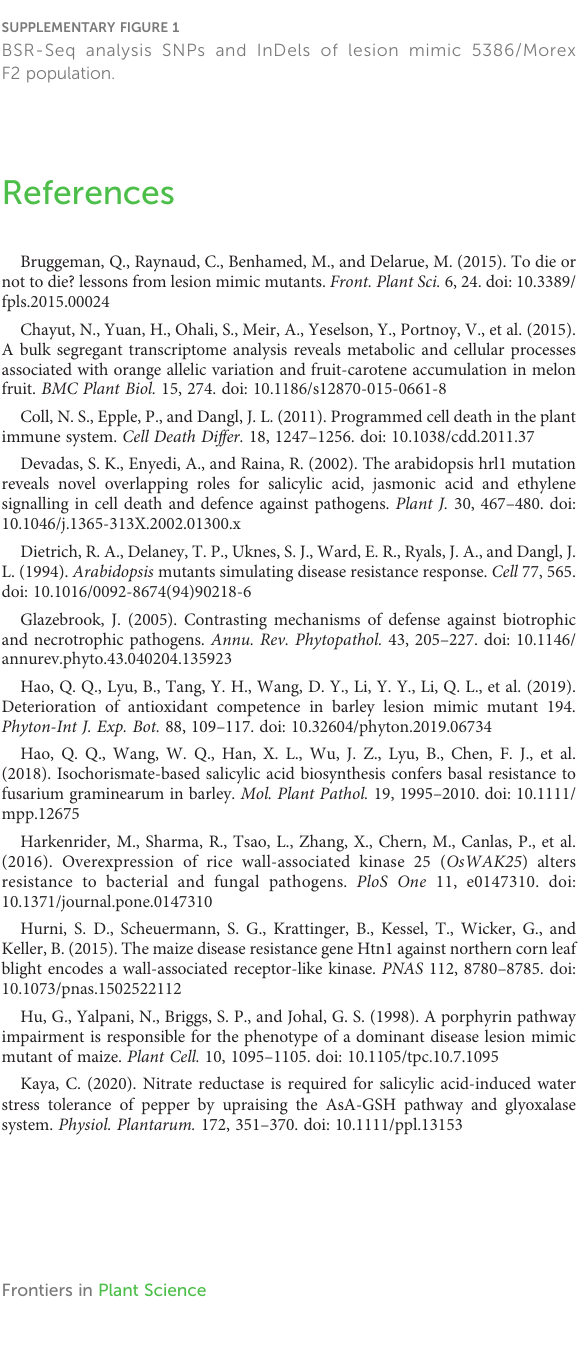
SUPPLEMENTARY FIGURE 2 Pearson correlation coef fi cients among three biological replicates of WT and LMM 5386 lines. SUPPLEMENTARY FIGURE 3 Hierarchical clustering analysis of nine differentially expressed genes (DEGs) based on the log (FC) of gene expression in Group 1. The color gradient from red to green represents relative levels of gene expression (from low to high, respectively). The numbers in the scale bar indicate the gene expression scores. SUPPLEMENTARY FIGURE 4 Phenotype differences on inoculated F. graminearum in leaves between WT and LMM 5386 lines. (A) Green fl uorescence phenotype at 3days after inoculation (DAI) and 7 DAI. (B) Integrated fl uorescence intensity (IFI) at 3 DAI and7DAI.Values aremeans±SDbasedonthirtyreplicates. Errorbars indicate standard deviations. *P < 0.05; **P < 0.01 SUPPLEMENTARY FIGURE 5 Phenotype differences on inoculated powdery mildew in leaves between WT and LMM 5386 lines. (A) Trypan blue staining of developing hyphae of Blumeria graminis f. sp. Hordei . (B) Length of fungal hyphae in infected plants. Values are means ± SD based on thirty replicates. Error bars indicate standard deviations. *P < 0.05; **P <